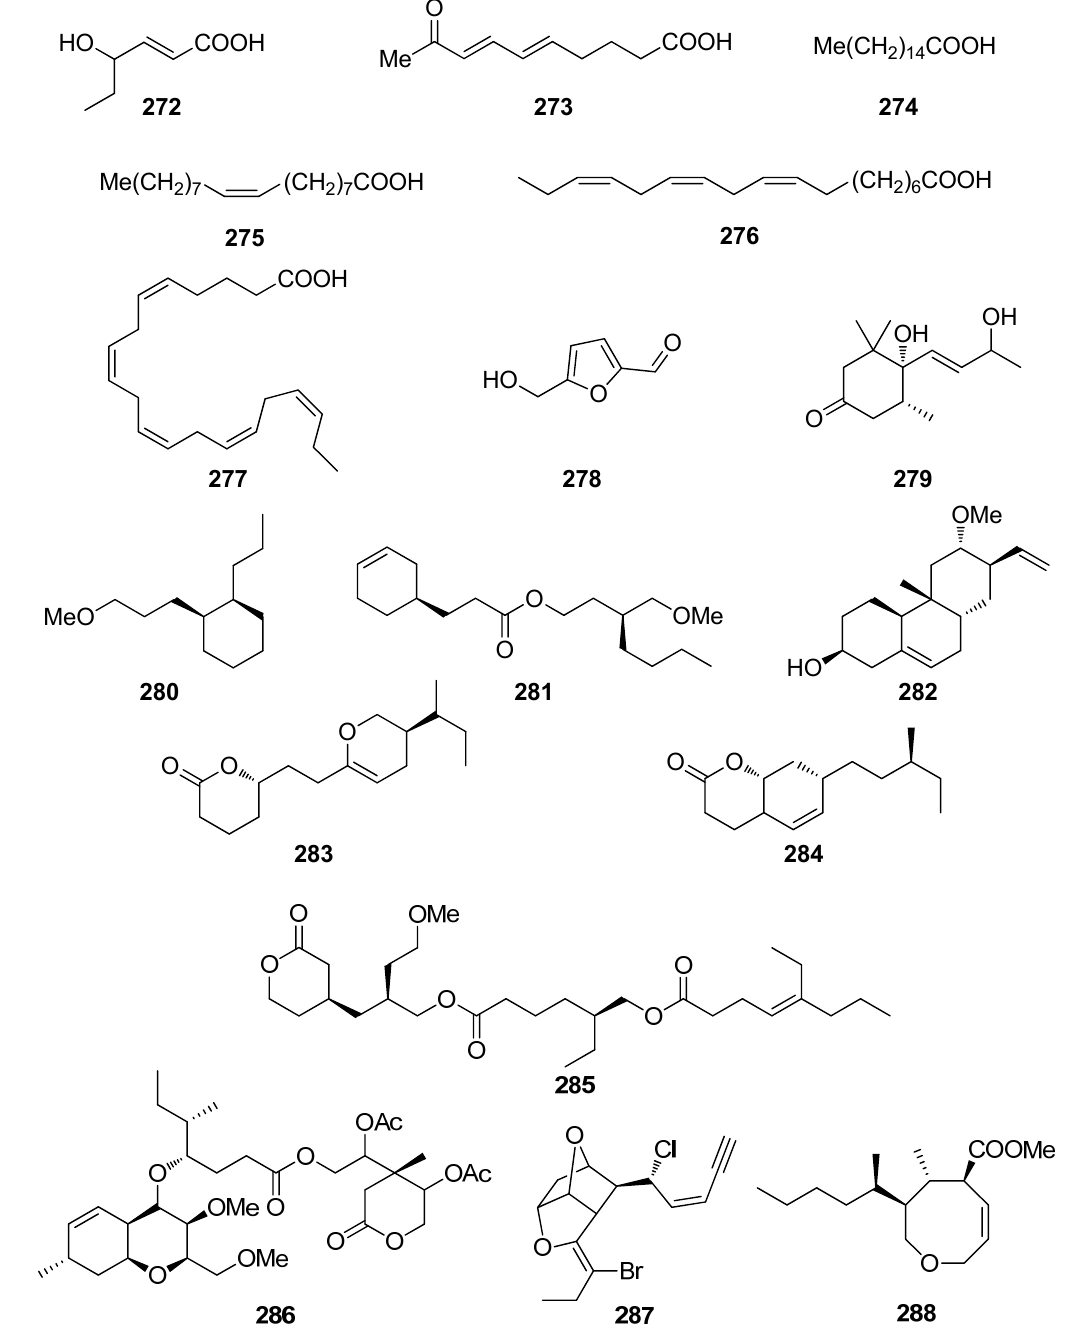
Figure 23. Chemical structures of compounds 272 – 288 .